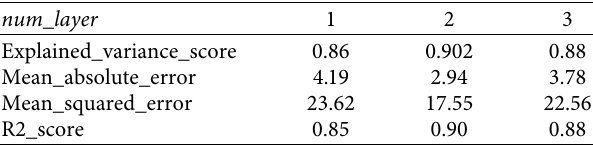
Table 2: Average test losses with different num_layers in